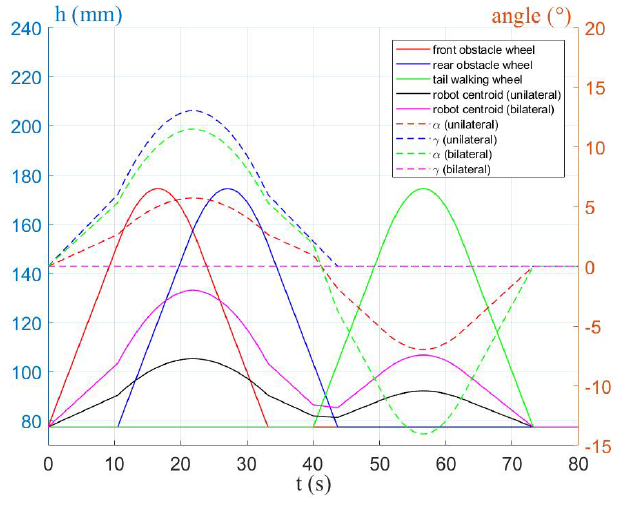
Figure 8. The curve of pitch angle α , roll angle γ , and centroid height 0 y 0 changing with time when the robot crosses the obstacle unilaterally or